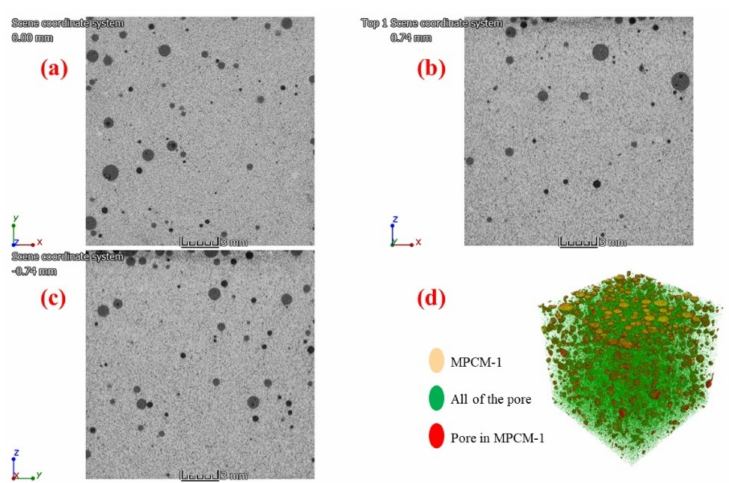
Figure 17. Slice images and 3D image model of the pores in CS.